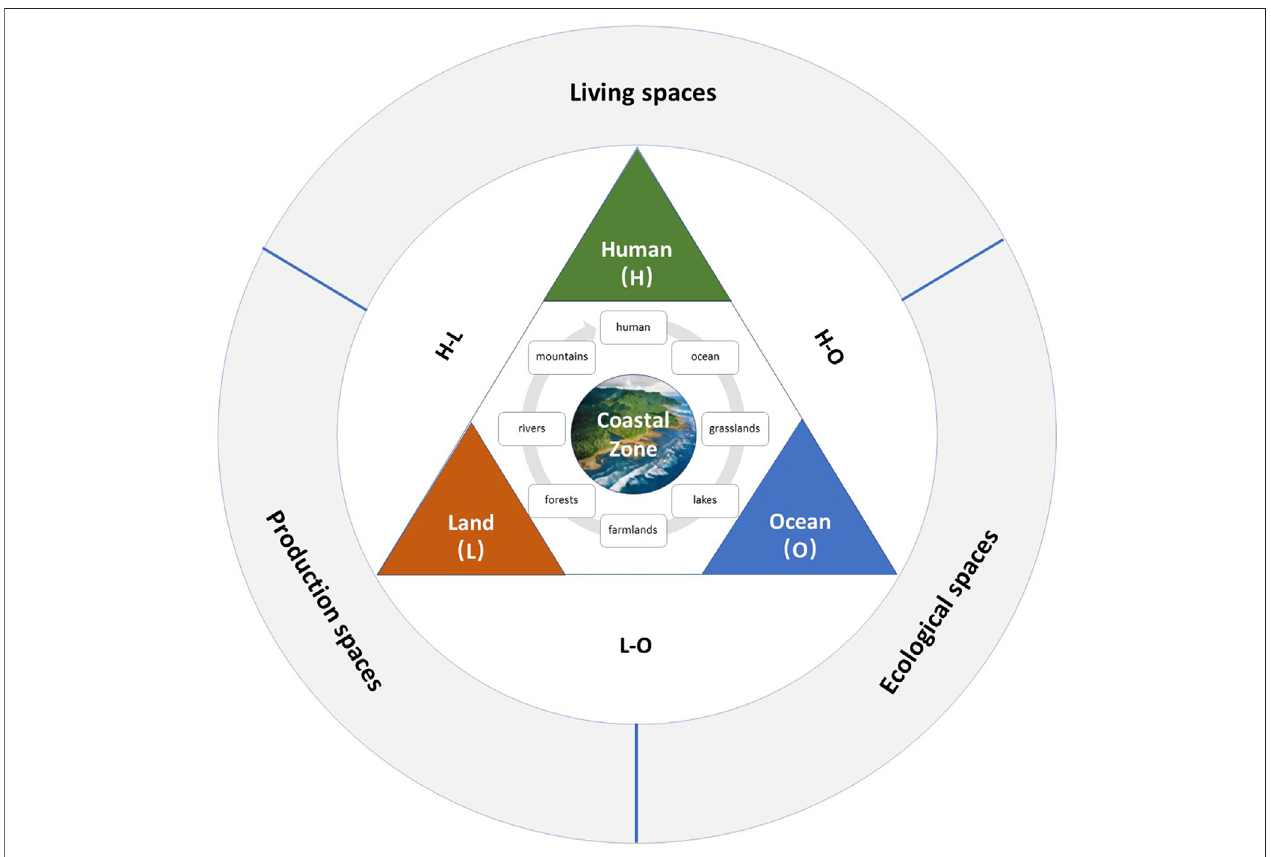
FIGURE 1 | Theoretical basis of the index system